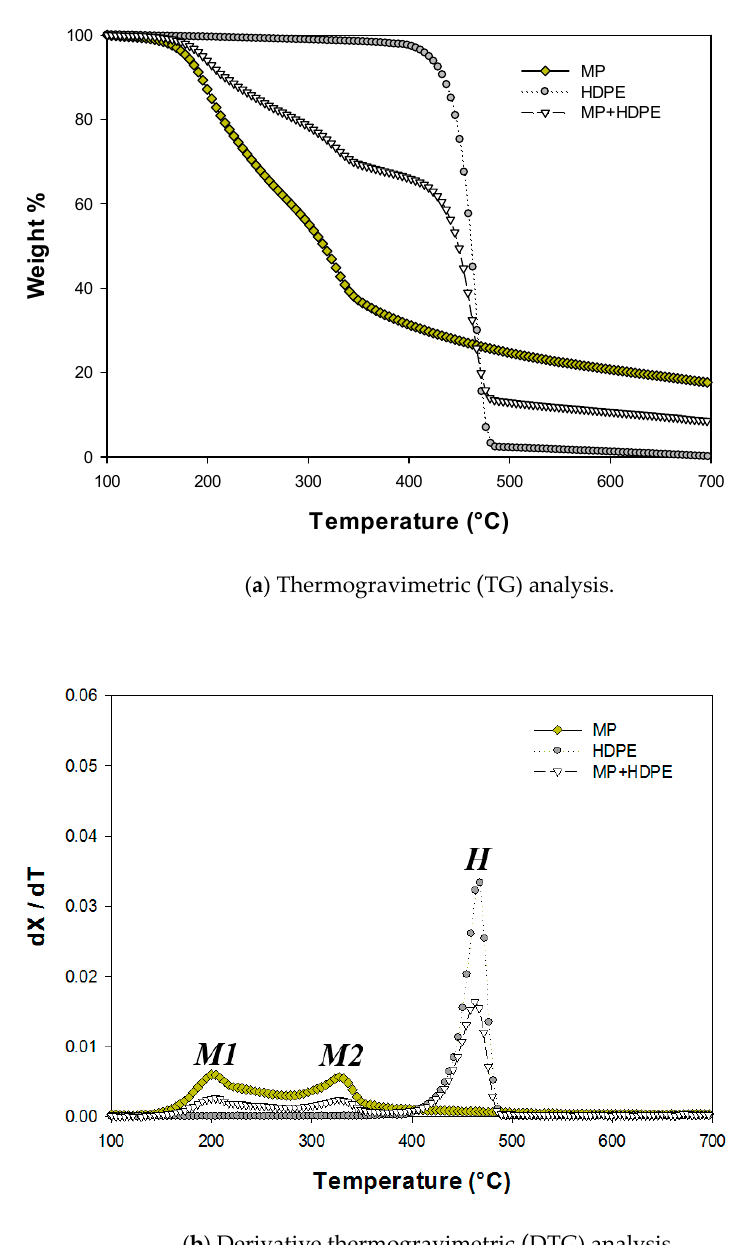
Figure 1. Non-catalytic TG and DTG curves of mandarin peel (MP), high-density polyethylene (HDPE), and their mixture at 5 °C/min.